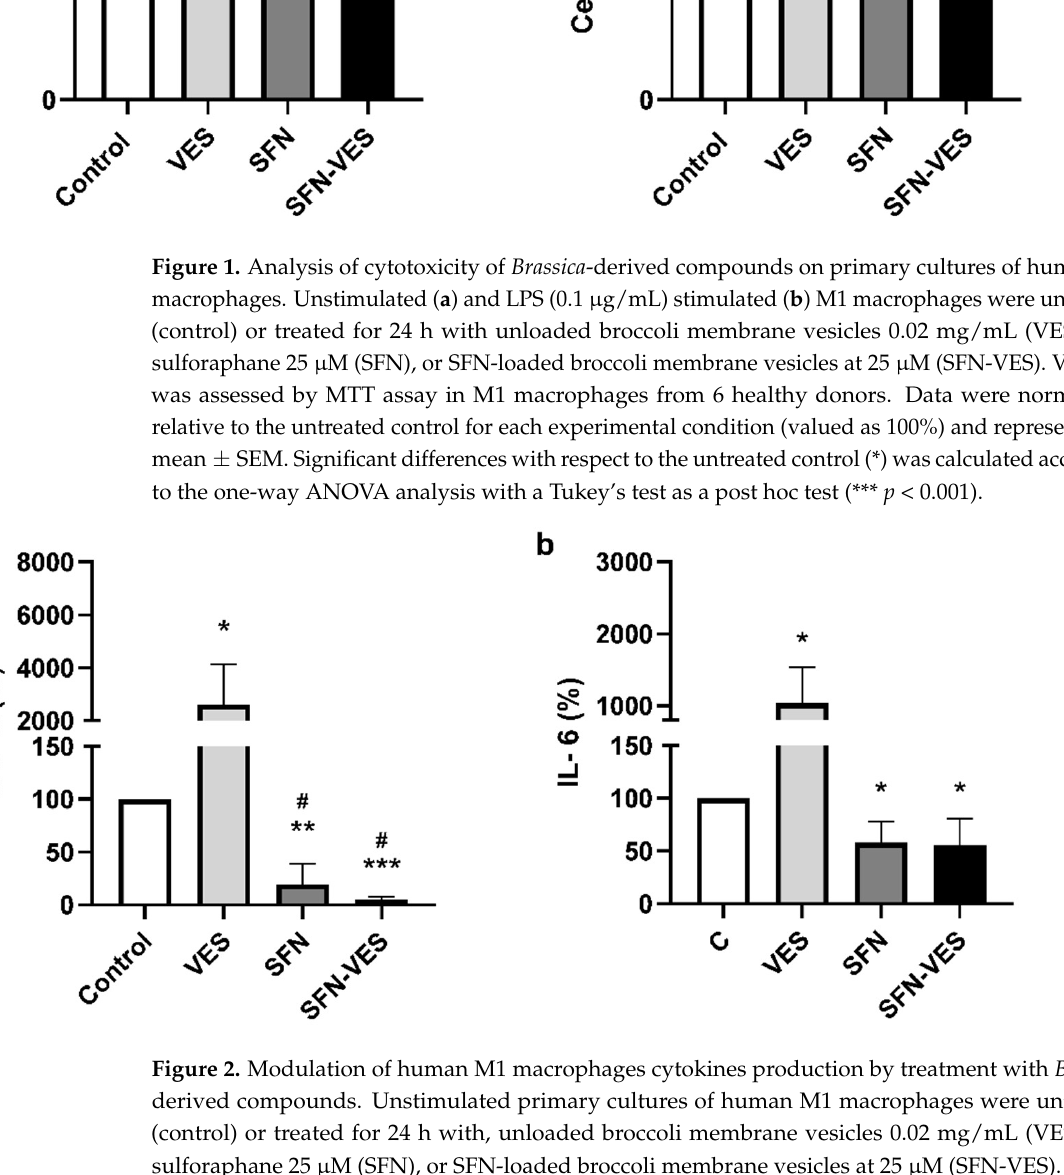
Figure 1. Analysis of cytotoxicity of Brassica- derived compounds on primary cultures of human M1 macrophages. Unstimulated ( a ) and LPS (0.1 µg/mL) stimulated ( b ) M1 macrophages were un- treated (control) or treated for 24 h with unloaded broccoli membrane vesicles 0.02 mg/mL (VES),